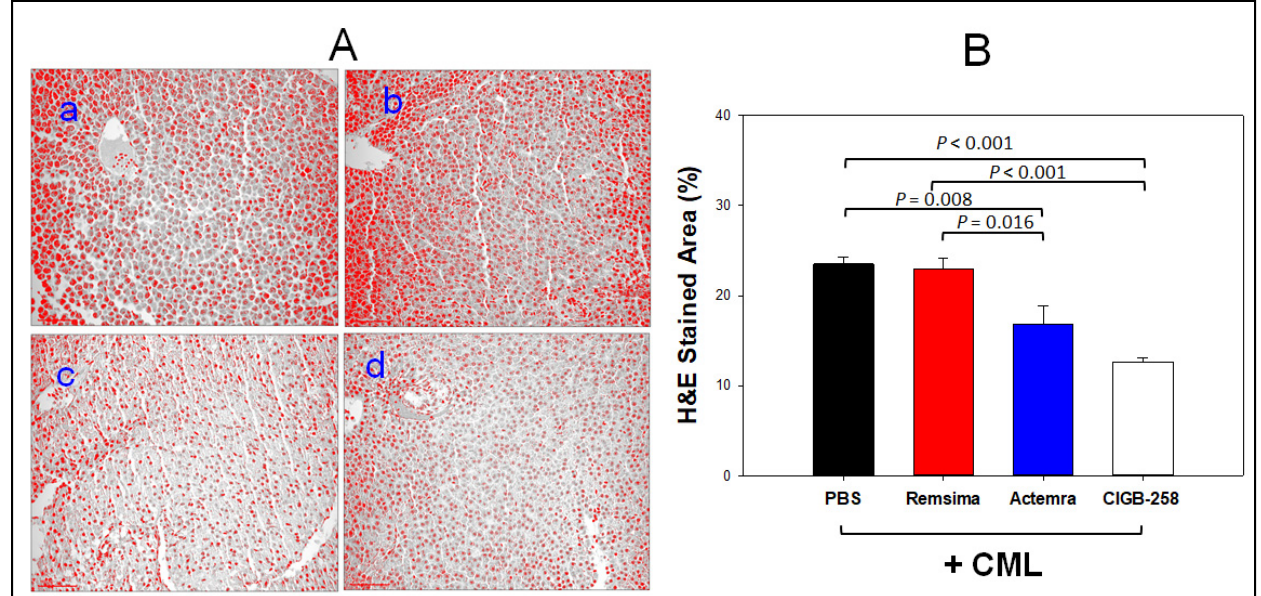
Figure 8. Histologic analysis of hepatic tissue from zebrafish injected with PBS (photo a), Remsima (Infliximab, photo b), Actemra (Tocilizumab, photo c), and CIGB-258 (photo d) in the presence of carboxymethyllysine (CML). ( A ) Visualization of the infiltration of neutrophils by Hematoxylin and Eosin (H&E) staining after converting the Hematoxylin-stained area into a red intensity with 400× magnification. ( B ) Quantification of the nucleus area from the H&E staining using Image J software (http://rsb.info.nih.gov/ij/ accessed on 16 May 2022). Statistical significances of among the groups were indicated as p values in the top of graph.